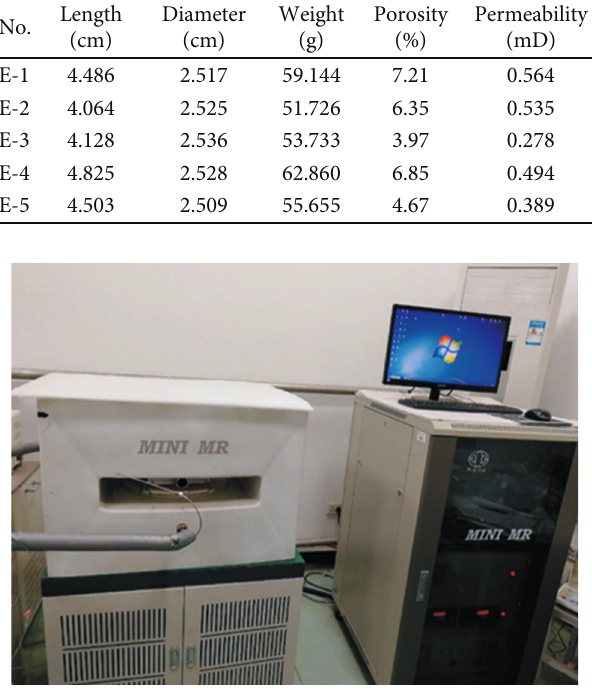
Figure 1: Low- fi eld NMR